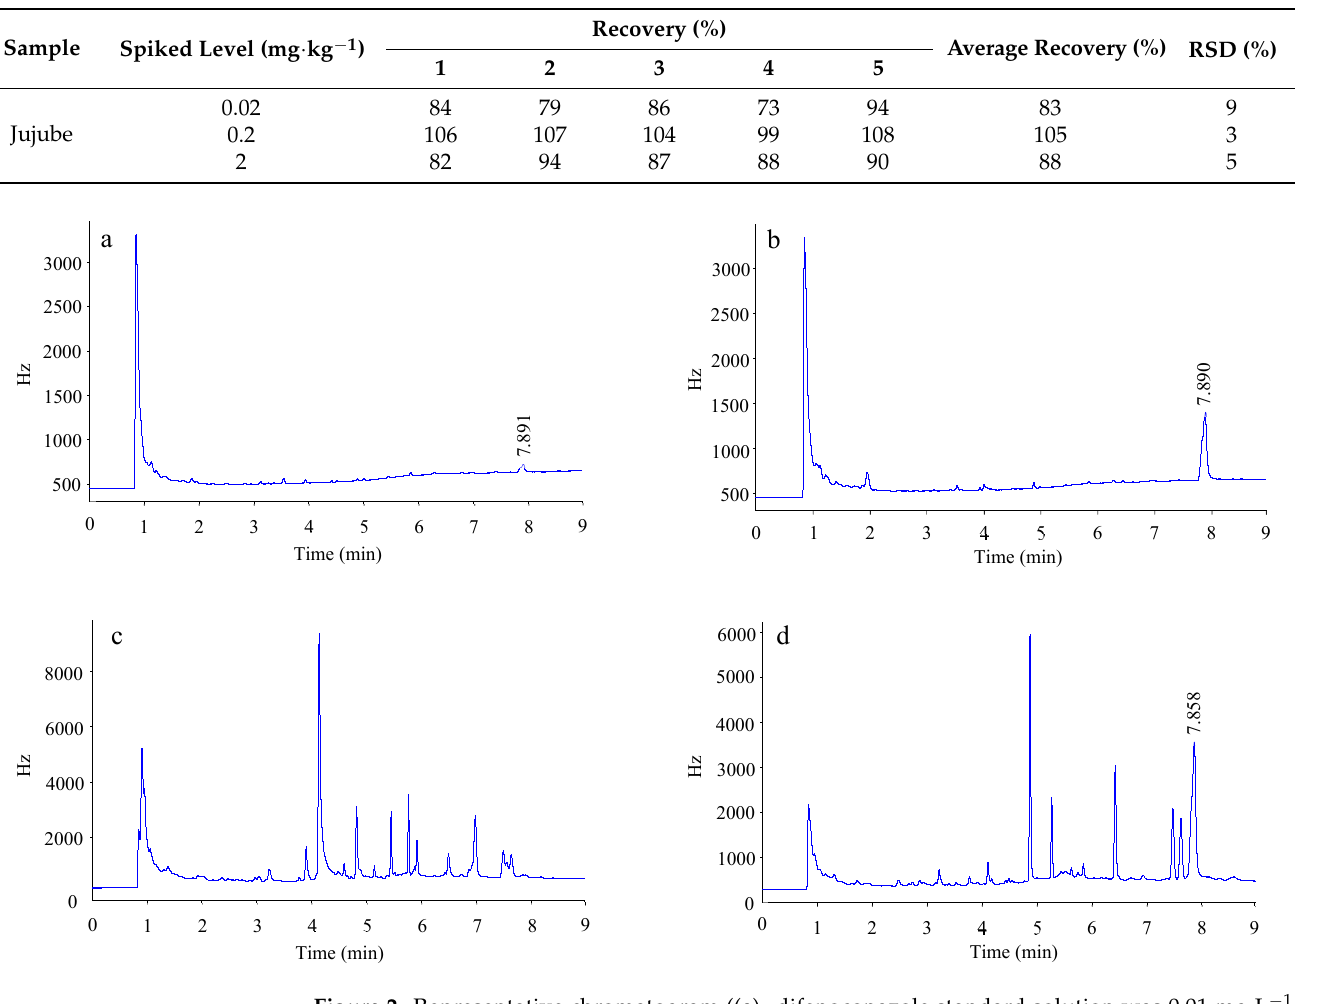
Figure 2. Representative chromatogram (( a ). difenoconazole standard solution was 0.01 mg · L − 1 , ( b ). difenoconazole standard solution was 0.1 mg · L − 1 , ( c ). jujube blank sample, ( d ). addition concentration for difenoconazole in jujube was 0.2 mg · kg − 1